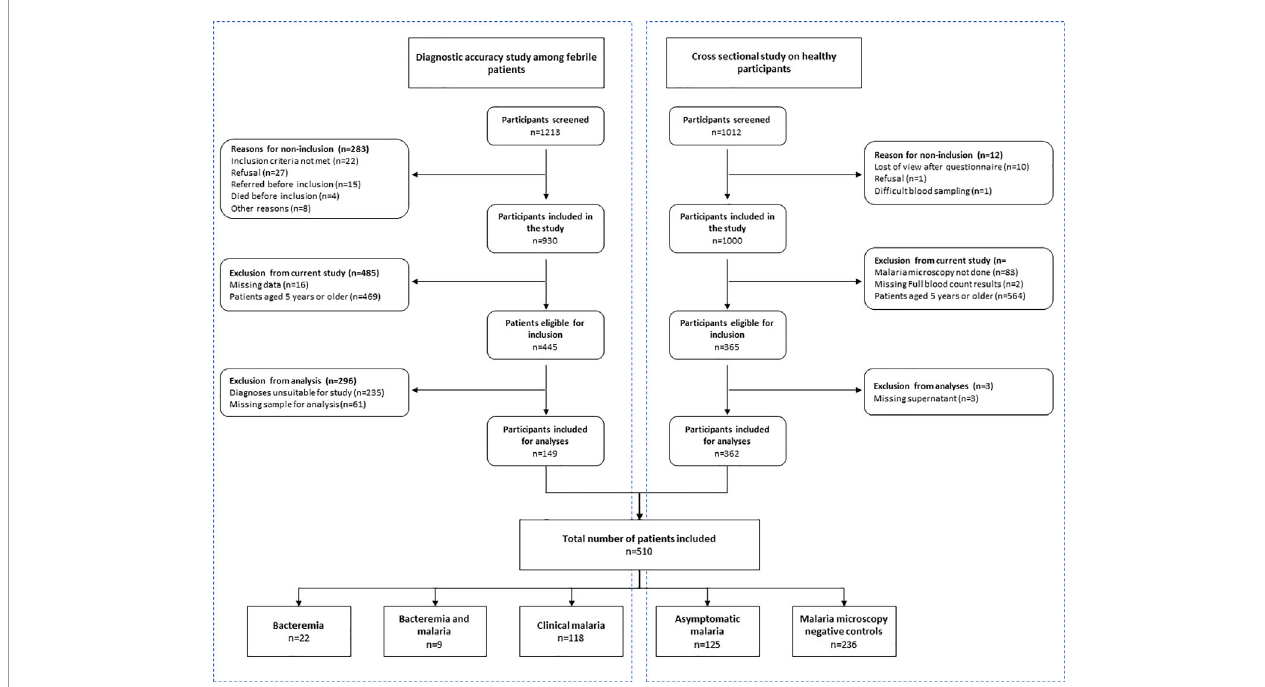
FIGURE 1 | Baseline characteristics of participants included in the current study; derived from participants to the diagnostic accuracy study among febrile patients and the cross-sectional study on healthy